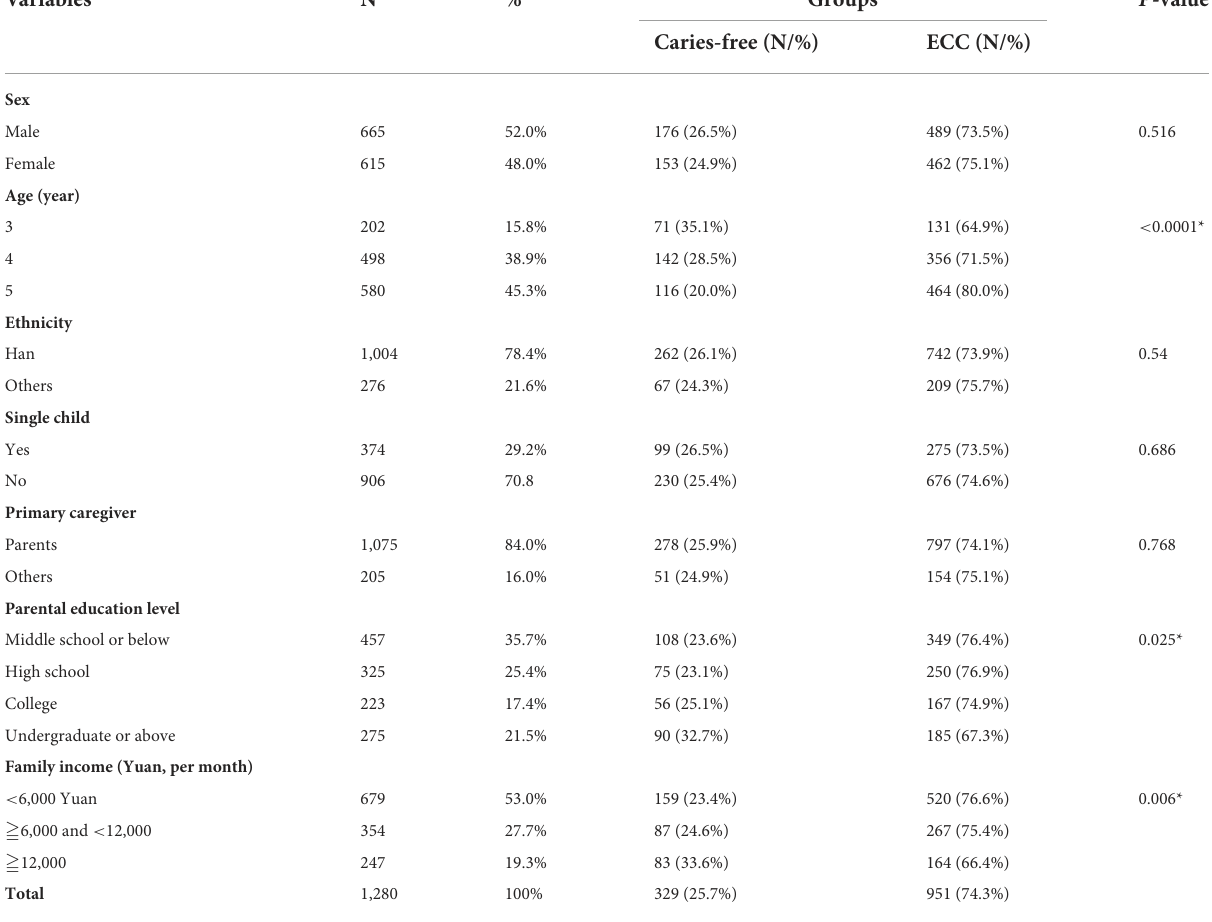
TABLE 1 Prevalence of ECC and socioeconomic factors ( N =